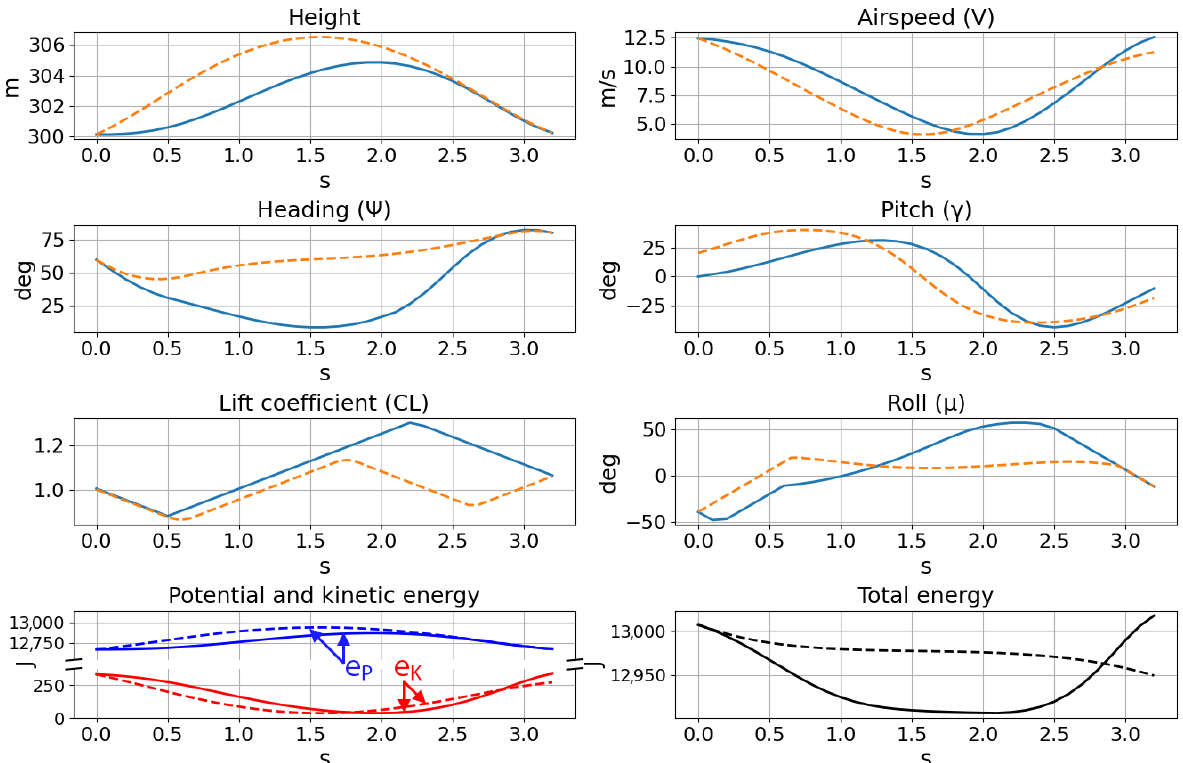
Figure 18. NEAT and TO traces of the dynamic soaring SUAV. The neurocontroller in solid lines; the optimized trajectory in dotted